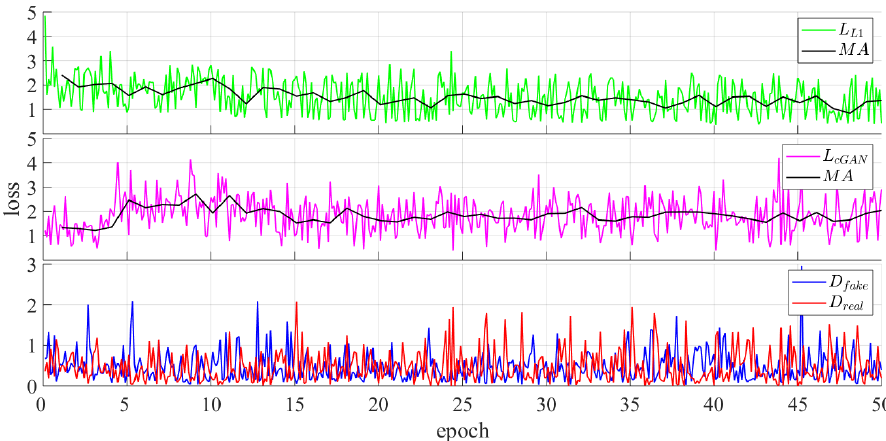
Figure 5. The loss of dataset 1 over time. MA means the moving average curve with the cycle of one epoch. D real indicates the curve of D ( x , y ) , and D fake represents the curve of D ( G ( z , y ) , y ) .